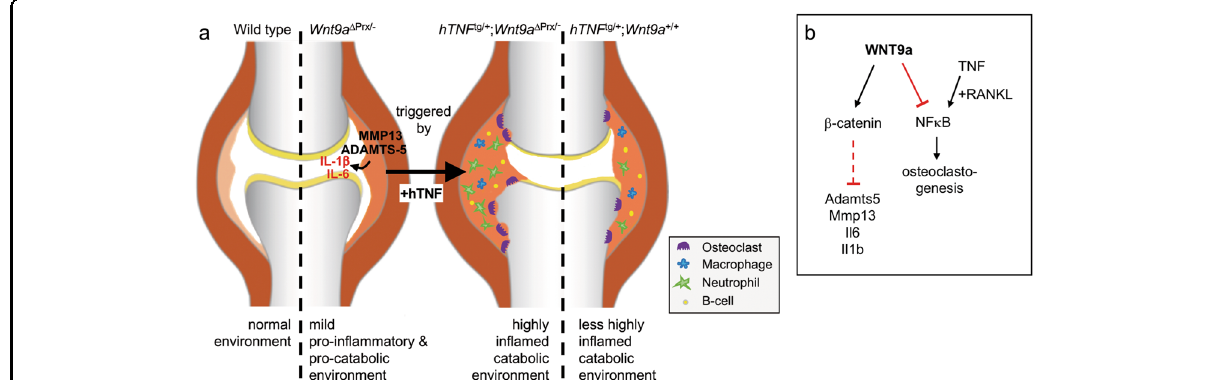
Fig. 7 Model comparing the alterations in joints of wild-type versus Wnt9a -de fi cient, hTNF tg/ + ; Wnt9a Δ Prx/ − , and hTNF tg/ + animals and pathways utilized by WNT9a to control environmental changes in the joint. a Compared to the situation in the wild-type, Wnt9a -de fi cient joints display a mild proin fl ammatory (slightly increased transcriptional levels of Il1b and Il6) and procatabolic (slightly increased transcriptional levels of Mmp13 and Adamts5) environment. In the hTNF tg/ + ; Wnt9a Δ Prx/ − joints, this is converted into a highly in fl amed catabolic environment through the activity of TNF. Due to the predispositioning in the Wnt9a -de fi cient joints, the effects of the TNF transgene are more intense compared to the alteration in hTNF tg/ + joints. b WNT9a acts on the one hand through the Wnt/ β -catenin pathway to maintain low transcriptional levels of the proin fl ammatory factors Il1b and Il6, and of the procatabolic factors Adamts5 and Mmp13 in synovial fi broblasts. On the other hand, WNT9a dampens the activity of the transcription factor NF κ B, which is required for osteoclastogenesis downstream of TNF and